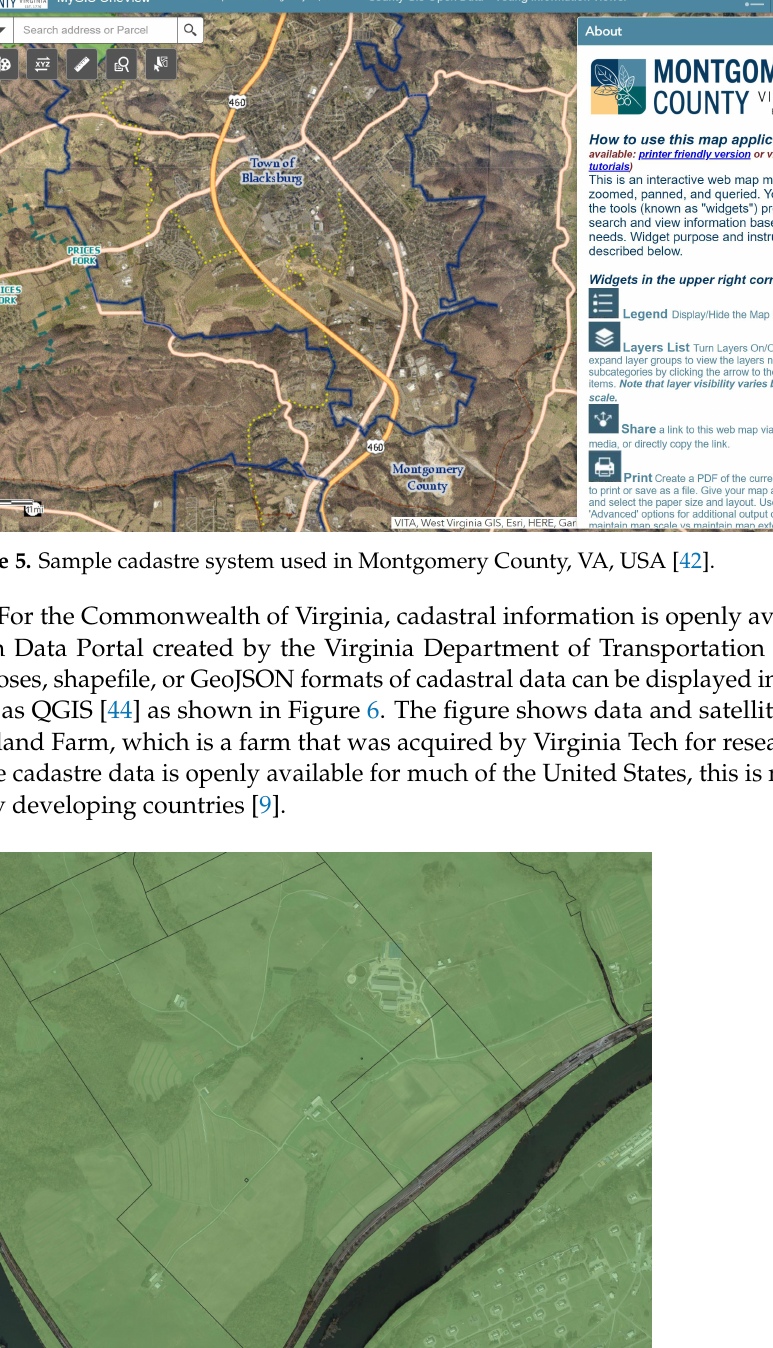
Figure 6. Property boundary data displayed in QGIS for the Virginia Tech Kentland research